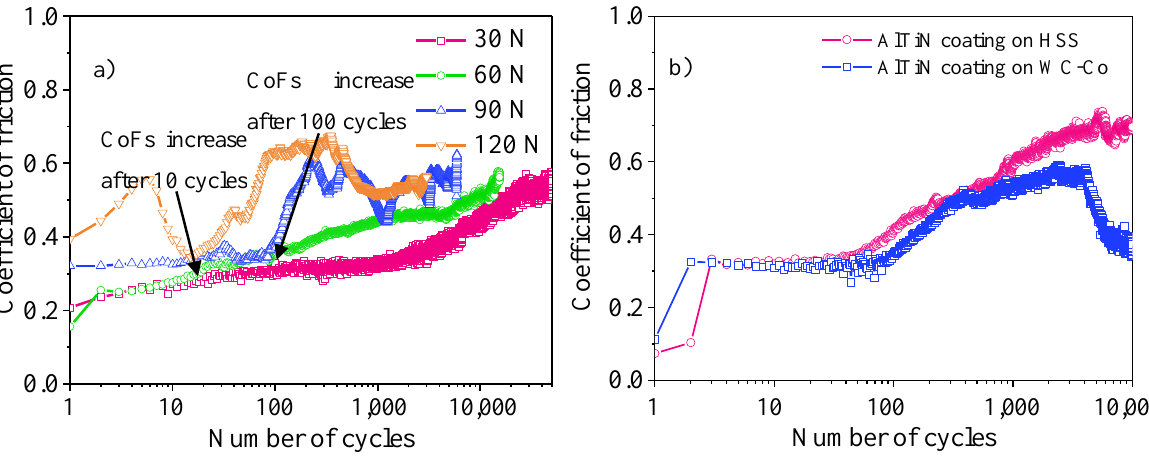
Figure 4. CoFs as a function of the number of cycles: ( a ) CrN coating on HSS substrate under different normal forces; ( b ) AlTiN coating on HSS and WC-Co substrates under 30 N normal force.